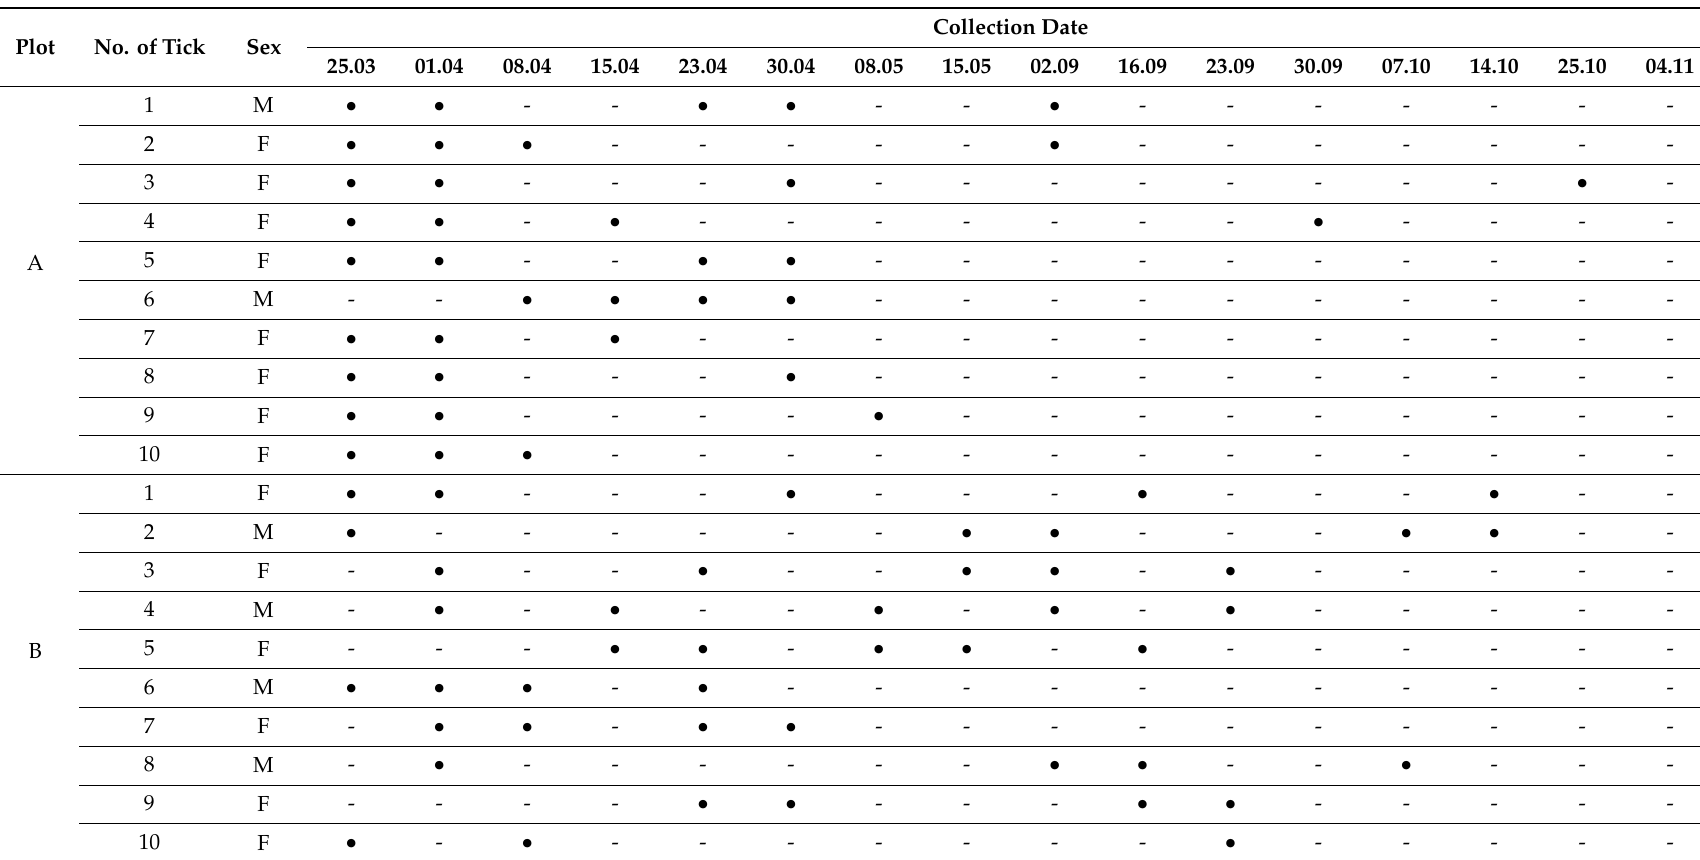
Table A1. 10 Dermacentor reticulatus adults undertaking the most intensive repetitive activity in the study plots in eastern Poland (2019).